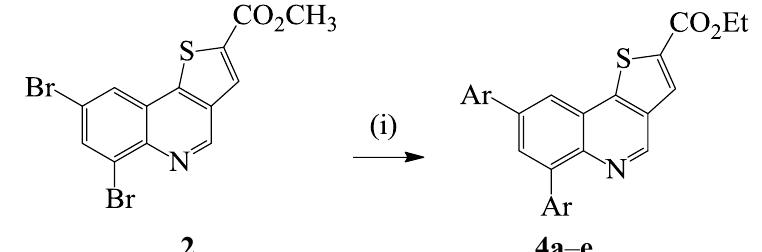
Scheme 2. One-pot Suzuki-Miyaura cross-coupling and trans-esterification of 2 to afford 4a – e .